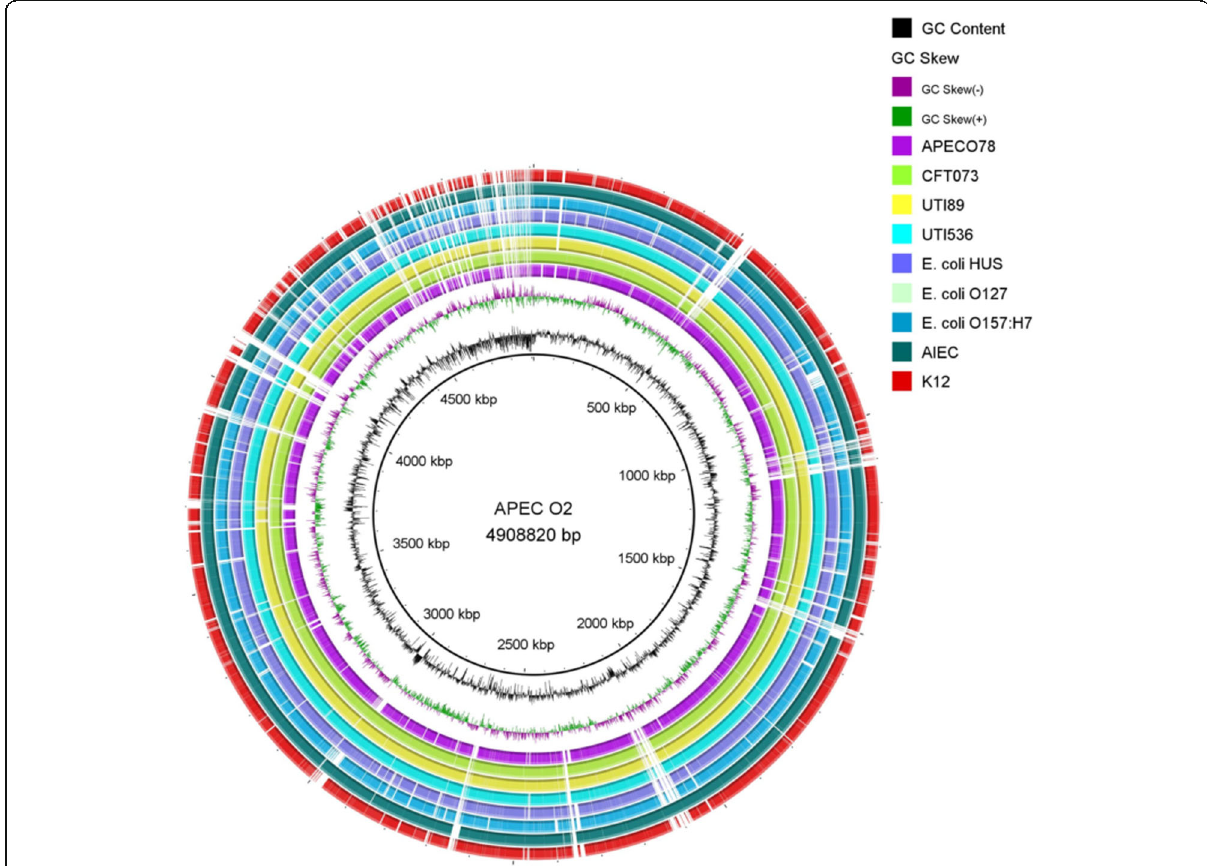
Fig. 3 Genomic comparison of APEC_O2 with other strains of Escherichia coli . Genome wide comparison of APEC_O2 with the complete genomes of another Avian pathogenic E. coli, APECO78 (CP004009.1), three isolates of human urinary pathogenic E. coli